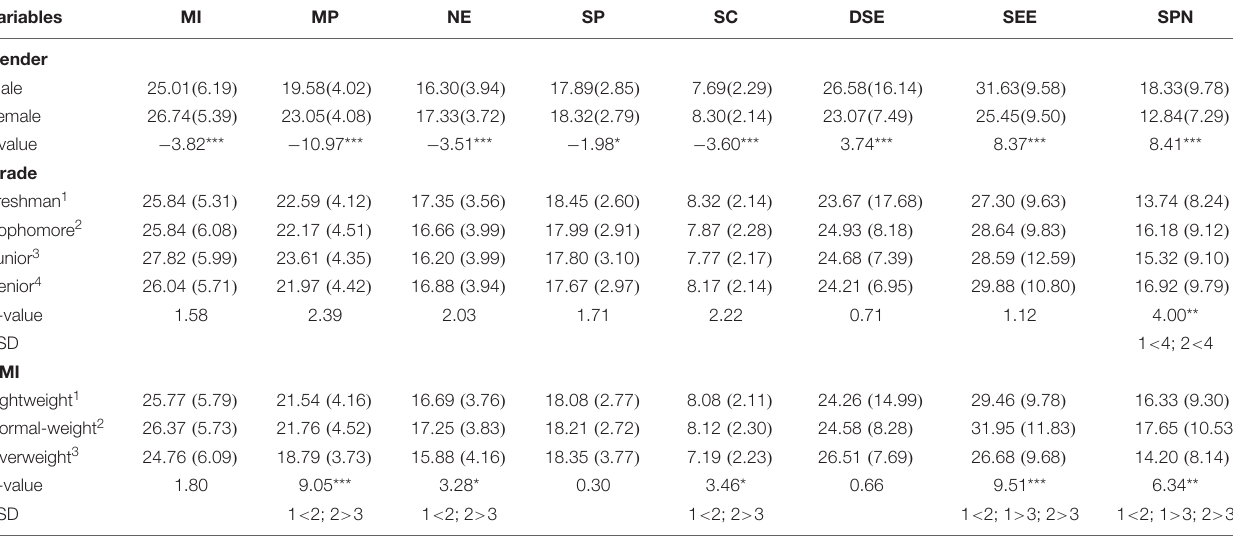
TABLE 3 | Comparison of differences in media internalized pressure, social physique anxiety, weight control efficacy, and sports participation by personal background in college students ( N = 1,194).